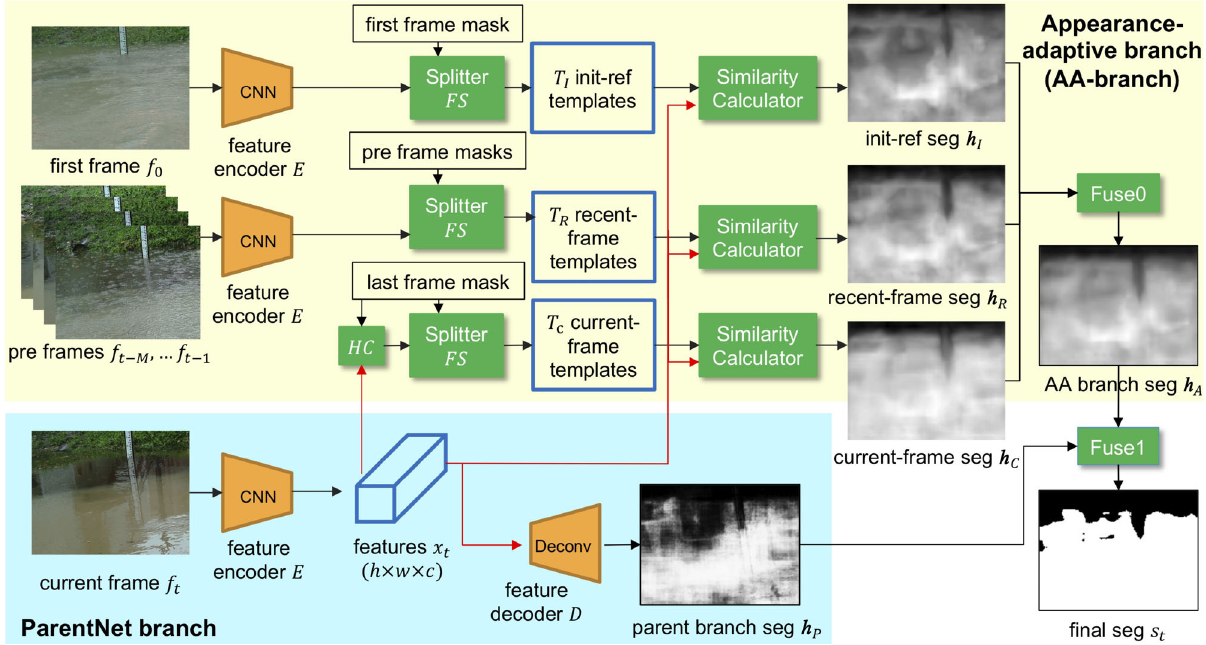
Fig. 2 Overview of WaterNet, which consists of a parent network (ParentNet) and an appearance-adaptive branch (AA-branch). They share the same feature encoder E , which generates features of input image. In ParentNet (blue background), a feature decoder D uses the current frame’s feature x t to predict a water segmentation h P . In the AA-branch (yellow background), a deterministic similarity calculator matches features of the current frame x t with feature templates T I , T R , T C , to predict water segmentations h I , h R , h C . Fusion modules merge these segmentations of the current frame to give the final segmentation s t